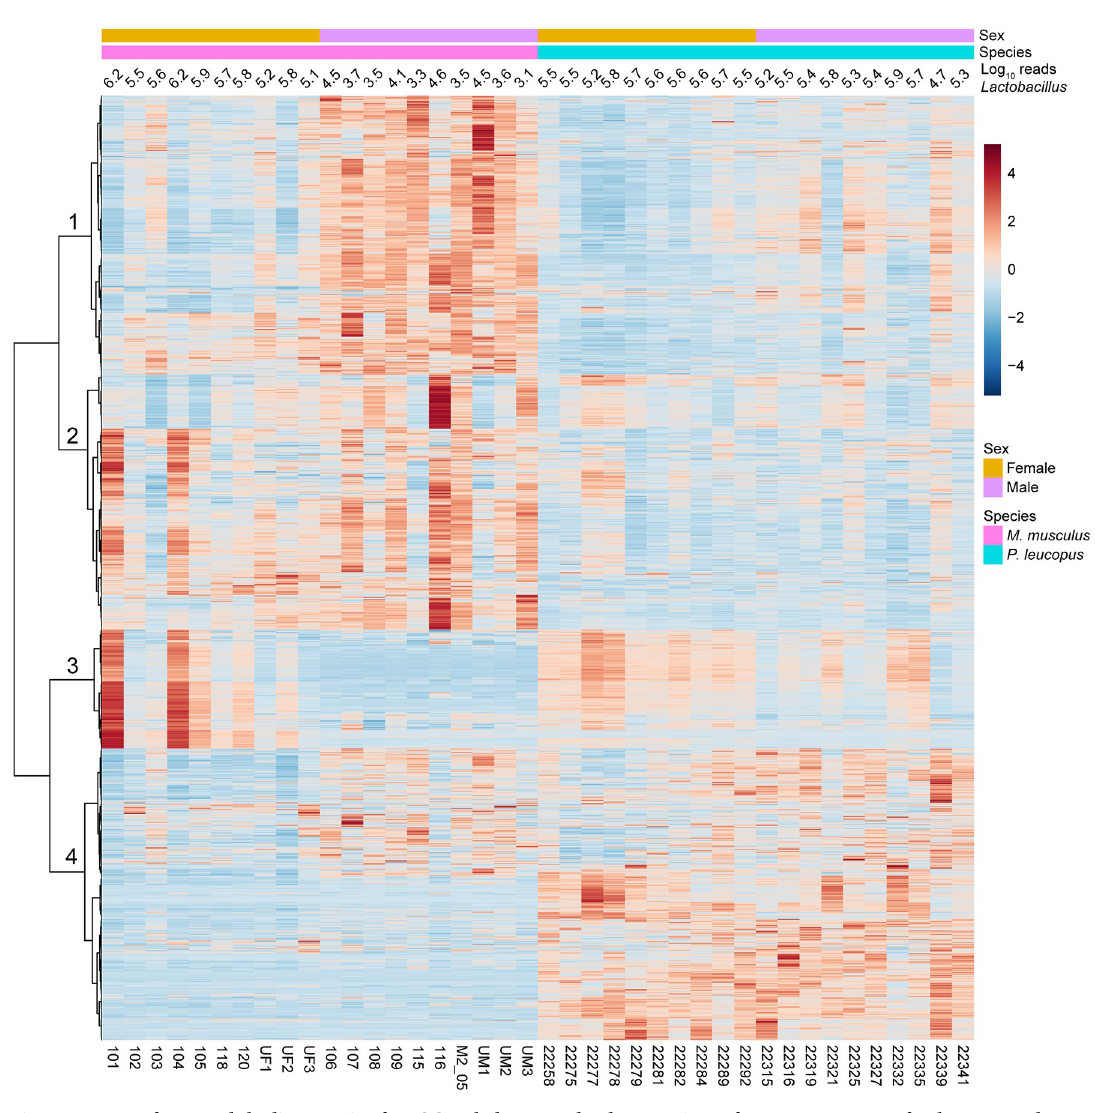
Fig 8. Heat map-formatted shading matrix of KEGG orthology gene level annotations of gut metagenomes of P . leucopus and M . musculus . The annotations were generated by MicrobiomeAnalyst (https://www.microbiomeanalyst.ca). Columns are grouped by species and by sex within each species. Individual animal identifications are given on the x -axis below the heat map. Above the heat map are the log-transformed reads mapping to the genus Lactobacillus for each animal’s fecal sample. Clustering of rows of genes were by Pearson correlation coefficient. Four major clusters are labeled 1–4 on the y -axis. Scaling is by relative abundances from low (blue) to high